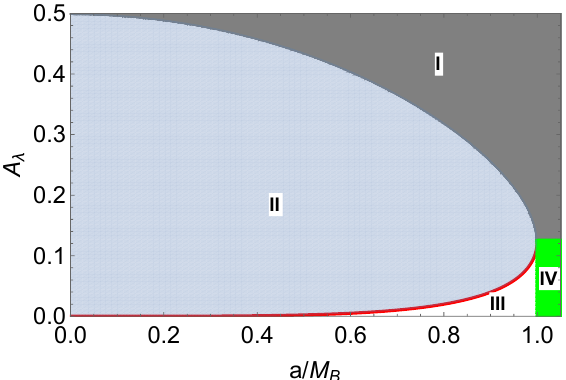
Figure 1 . The dependence of the number of horizons on the parameters A λ and a . The numbers of horizons in regions I, II, III, and IV are 0, 1, 2 and 0, respectively. Region I has been almost ruled out by the shadow size of M87* measured by